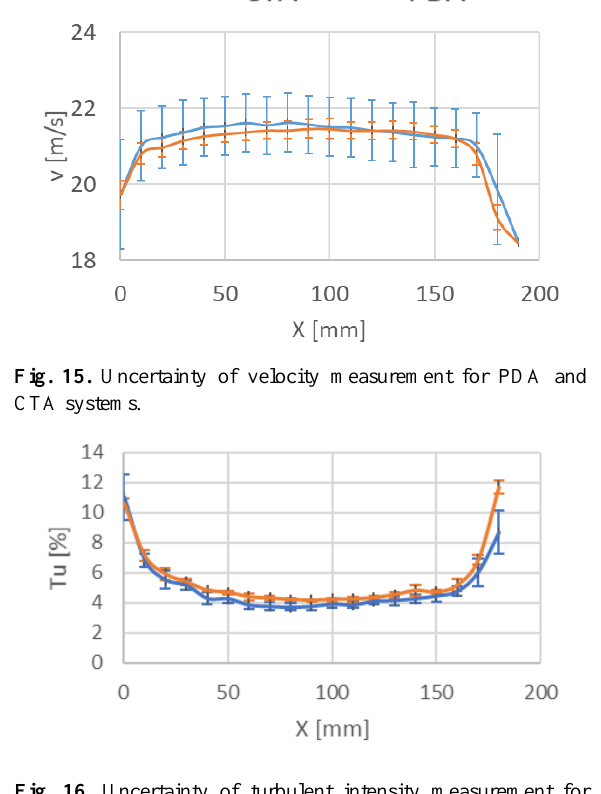
Fig. 16. Uncertainty of turbulent intensity measurement for PDA and CTA systems .